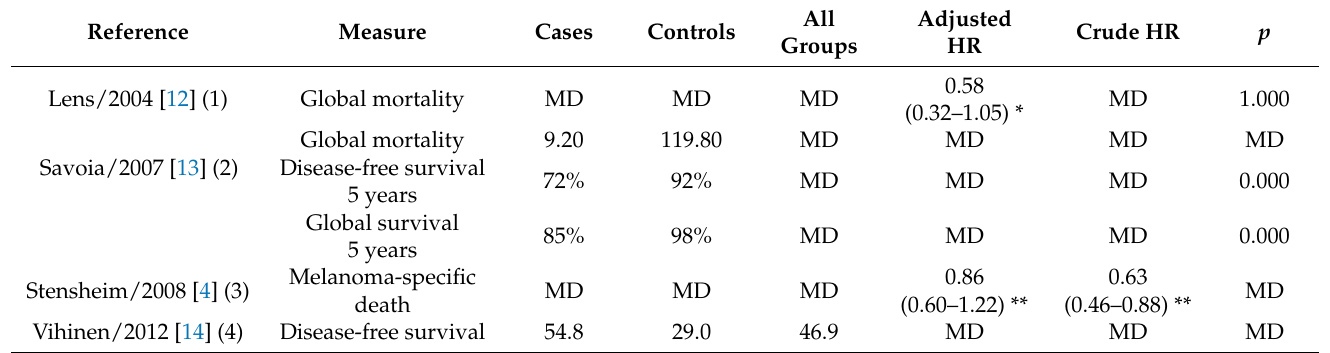
Table 3. Disease